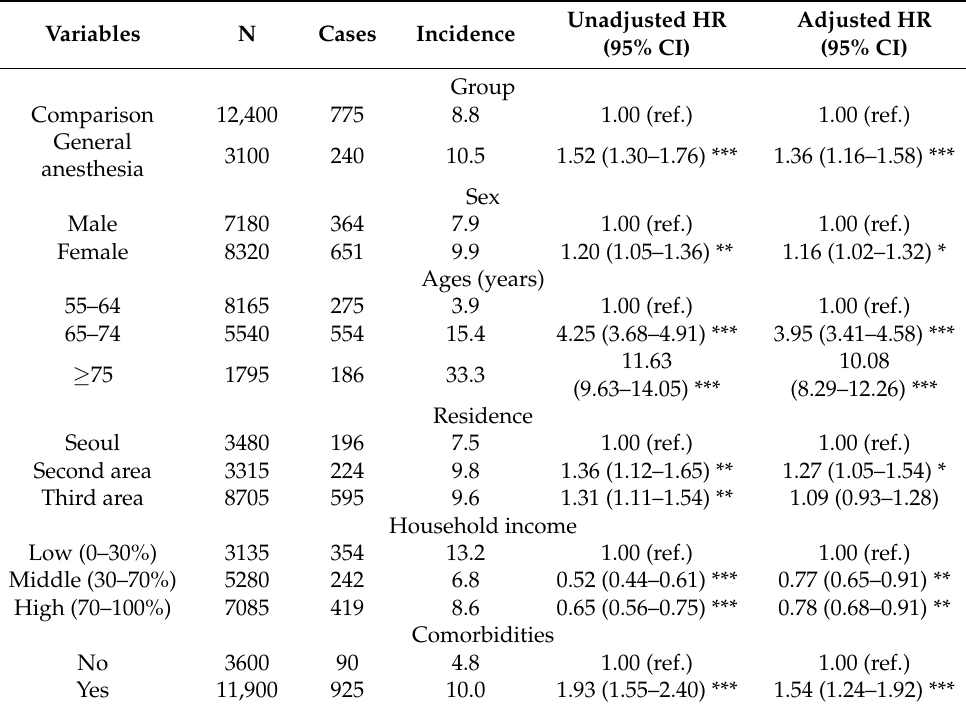
Table 2. Incidence per 1000 person-years and the HR (95% CI) of dementia.